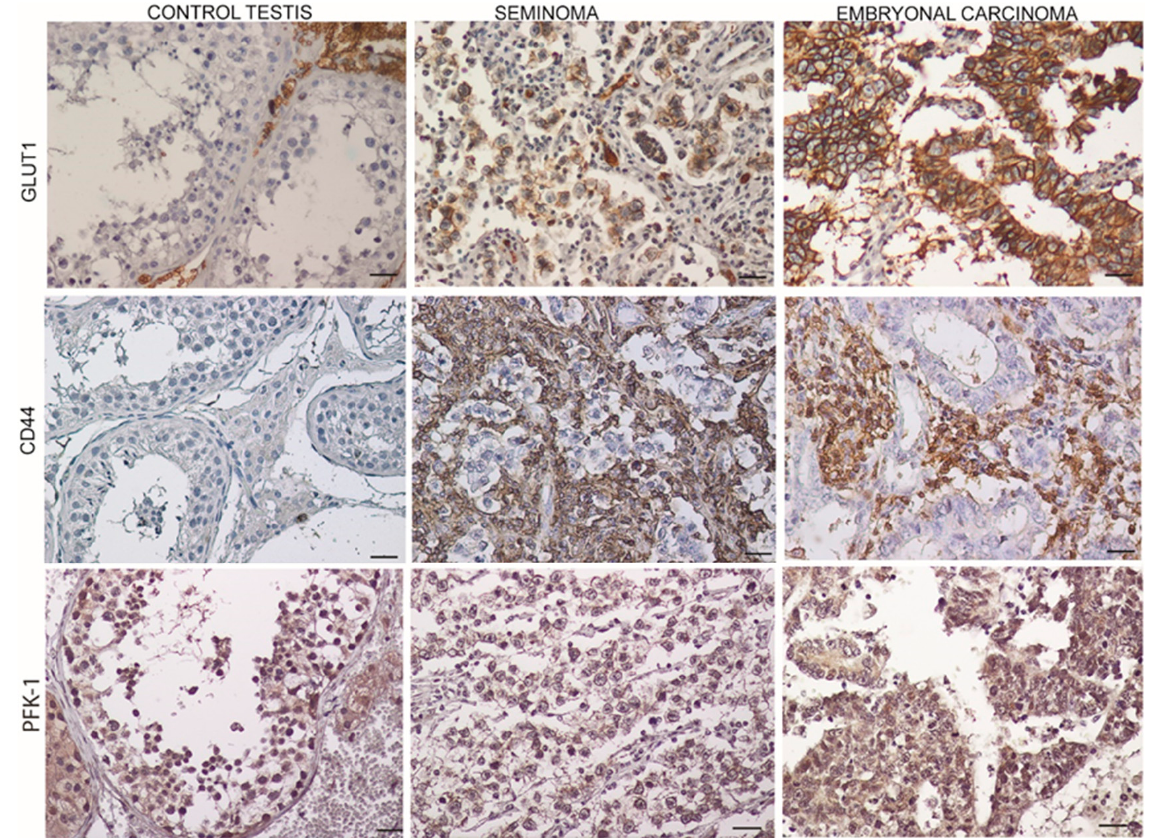
Figure 2. Expression markers of aerobic glycolysis in control testis and TGCTs. Scale bars: 25 μ m. Glucose transporter 1 (GLUT1); Type 1 transmembrane glycoprotein (CD44); Phosphofructokinase-1 (PFK-1).